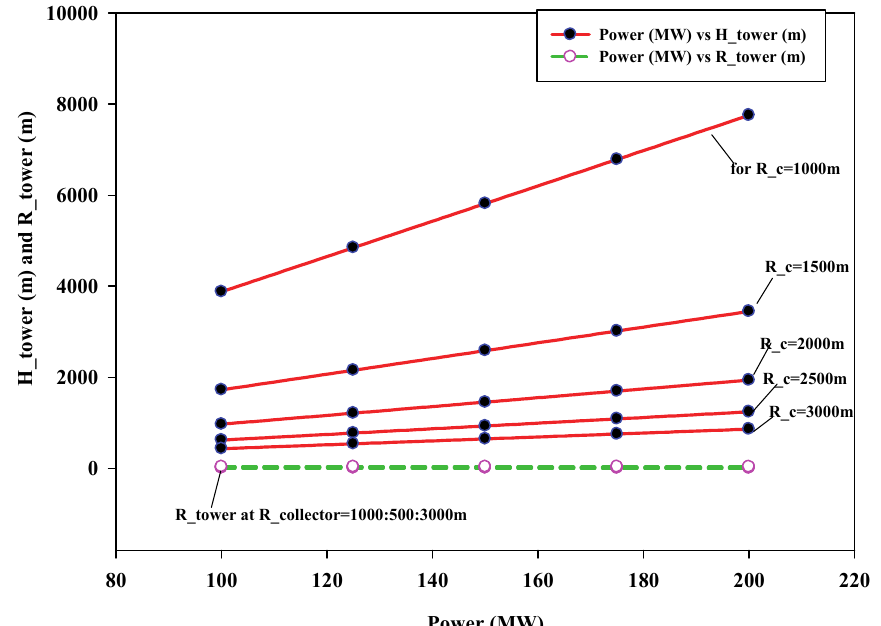
Figure 18. Effect of variation in power output on tower height ( H Tower ) and tower radius ( R Tower ) for different collector radii ( R Collector ) in SUTPP.